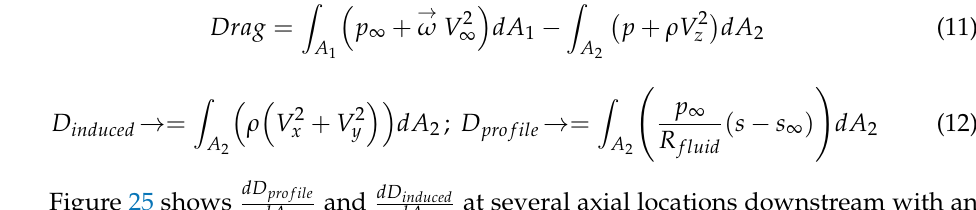
Figure 25. Contour plots dD profile